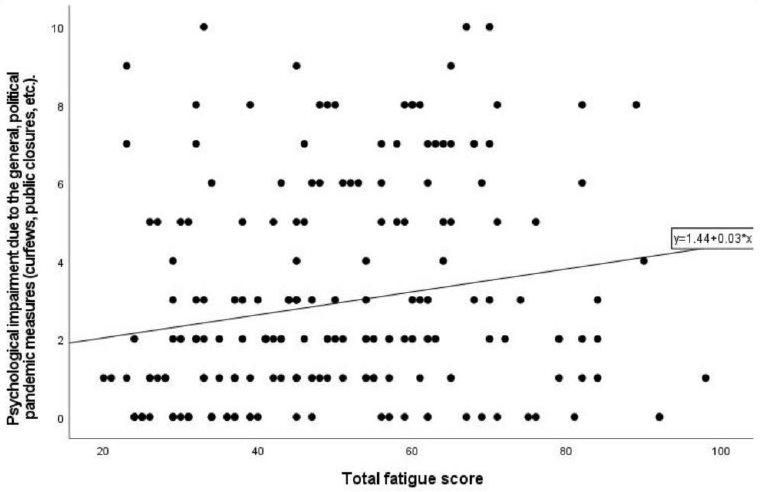
Figure 1. Correlation between psychological impairment due to general, political pandemic measures (curfews, public closures, etc.) and total fatigue score.